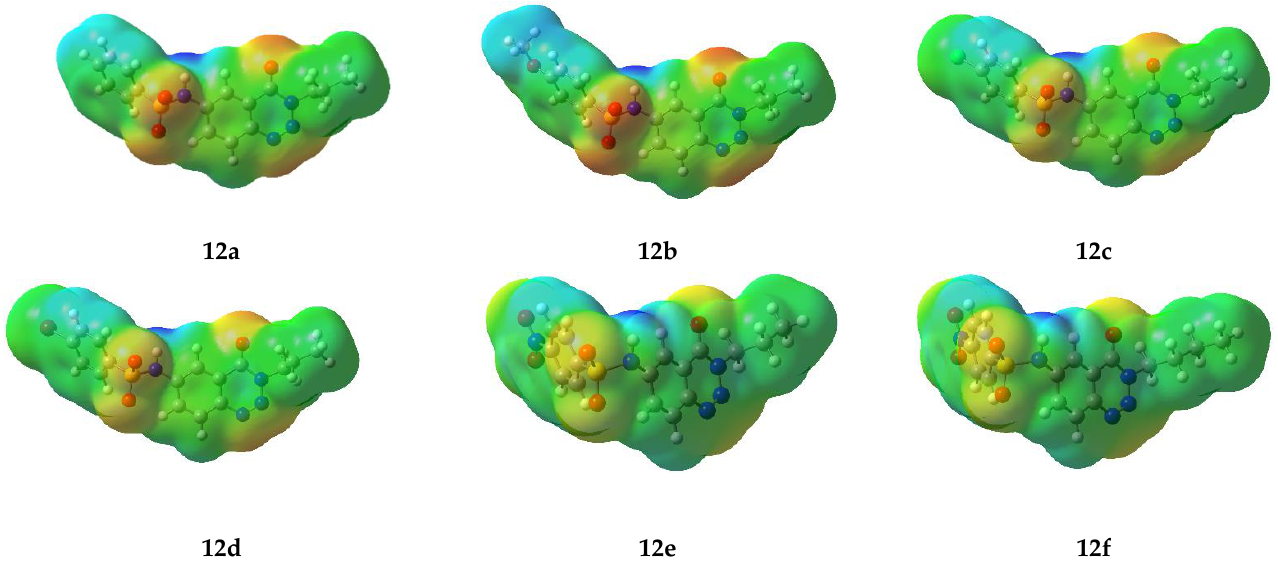
Figure 6. Electrostatic potential on the surfaces of 1,2,3-benzotriazin-4(3 H )-one sulfonamides.